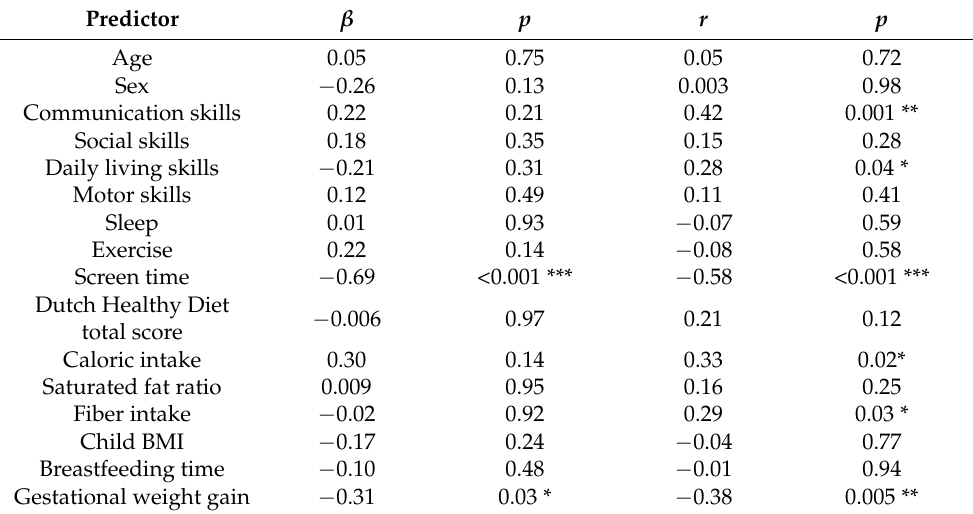
Table 2. Significance of the lifestyle factors in the exploratory regression analysis predicting perfor- mance in the spatial cognition task (i.e., Mean percentage correct as the dependent variable).